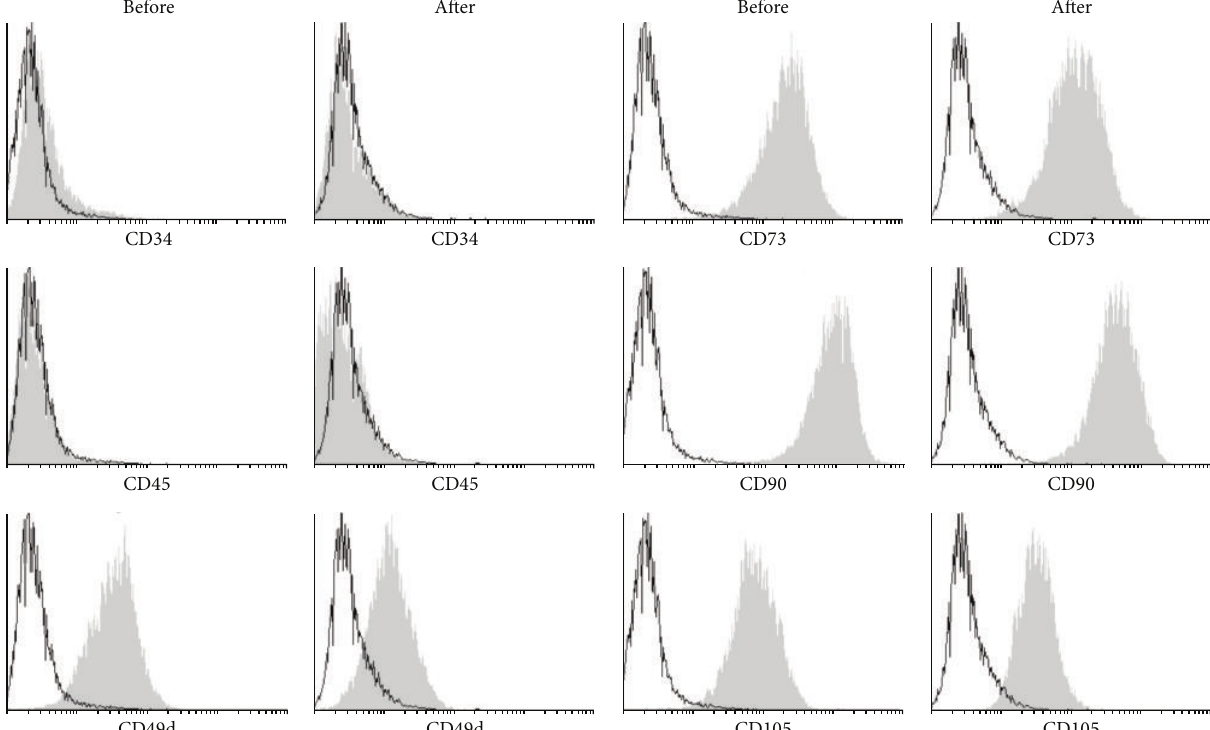
Figure 2: Histograms of ADMSC markers before and after cryopreservation. The grey color represents specific marker and the white color represents an isotype control.